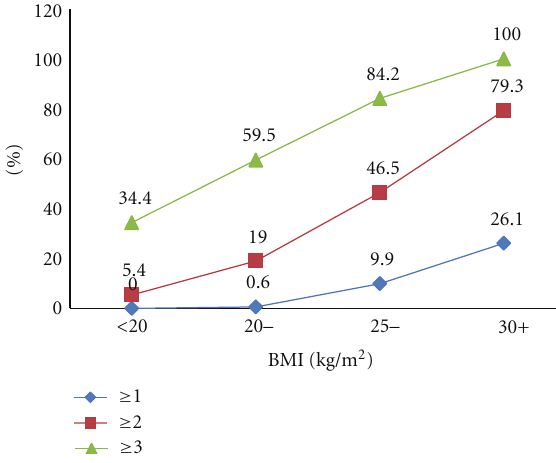
Figure 2: Prevalence of the ≥ 1, ≥ 2, and ≥ 3 metabolic abnormalities among Saudi college students by BMI